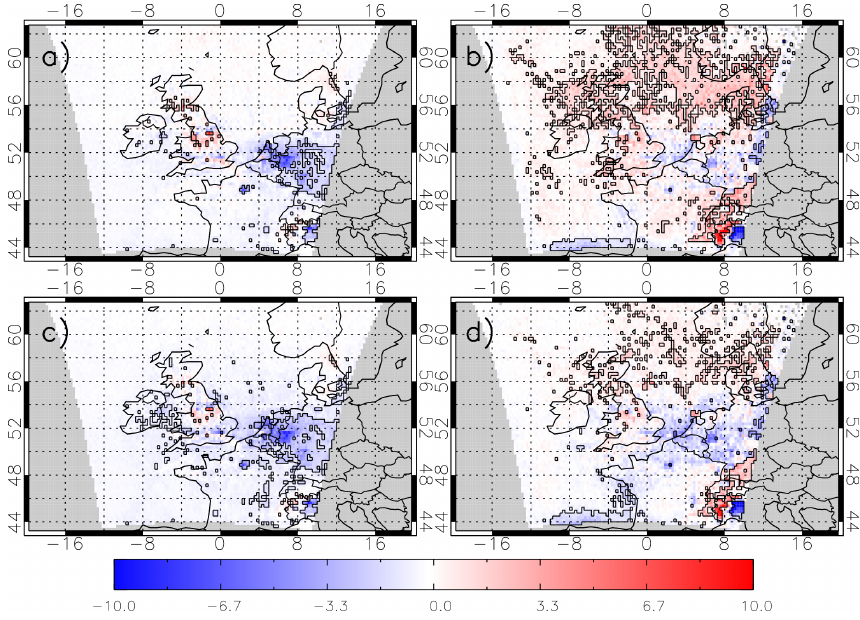
Figure 9. MB in tropospheric NO 2 column ( × 10 15 moleculescm − 2 ), 2006, between AQUM (AKs applied)–OMI for (a) summer γ = 0.001 (RMSE = 3.39 × 10 15 moleculescm − 2 and FGE = 0.65), (b) winter γ = 0.001 (RMSE = 5.05 × 10 15 moleculescm − 2 and FGE = 0.62), (c) summer γ = 0.02 (RMSE = 3.08 × 10 15 moleculescm − 2 and FGE = 0.67) and (d) winter γ = 0.02 (RMSE = 4.48 × 10 15 moleculescm − 2 and FGE =